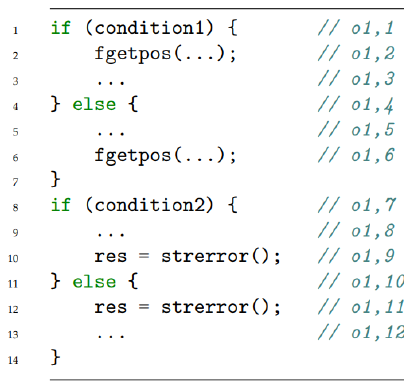
Figure 3. Advanced example of